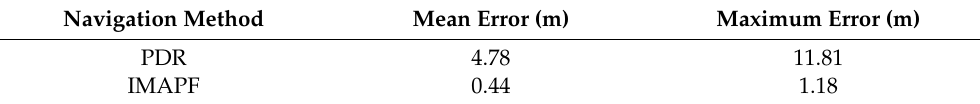
Table 2. Error comparison under the condition that the initial position and heading are known.